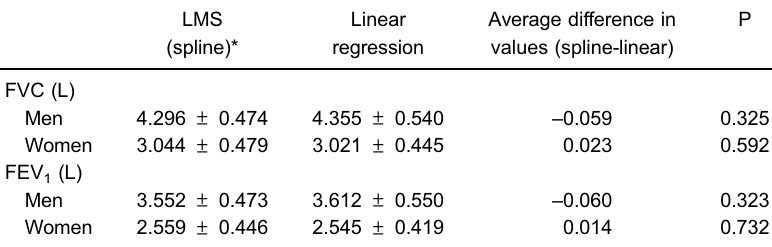
Table 6. FVC and FEV 1 values obtained through the LMS and linear